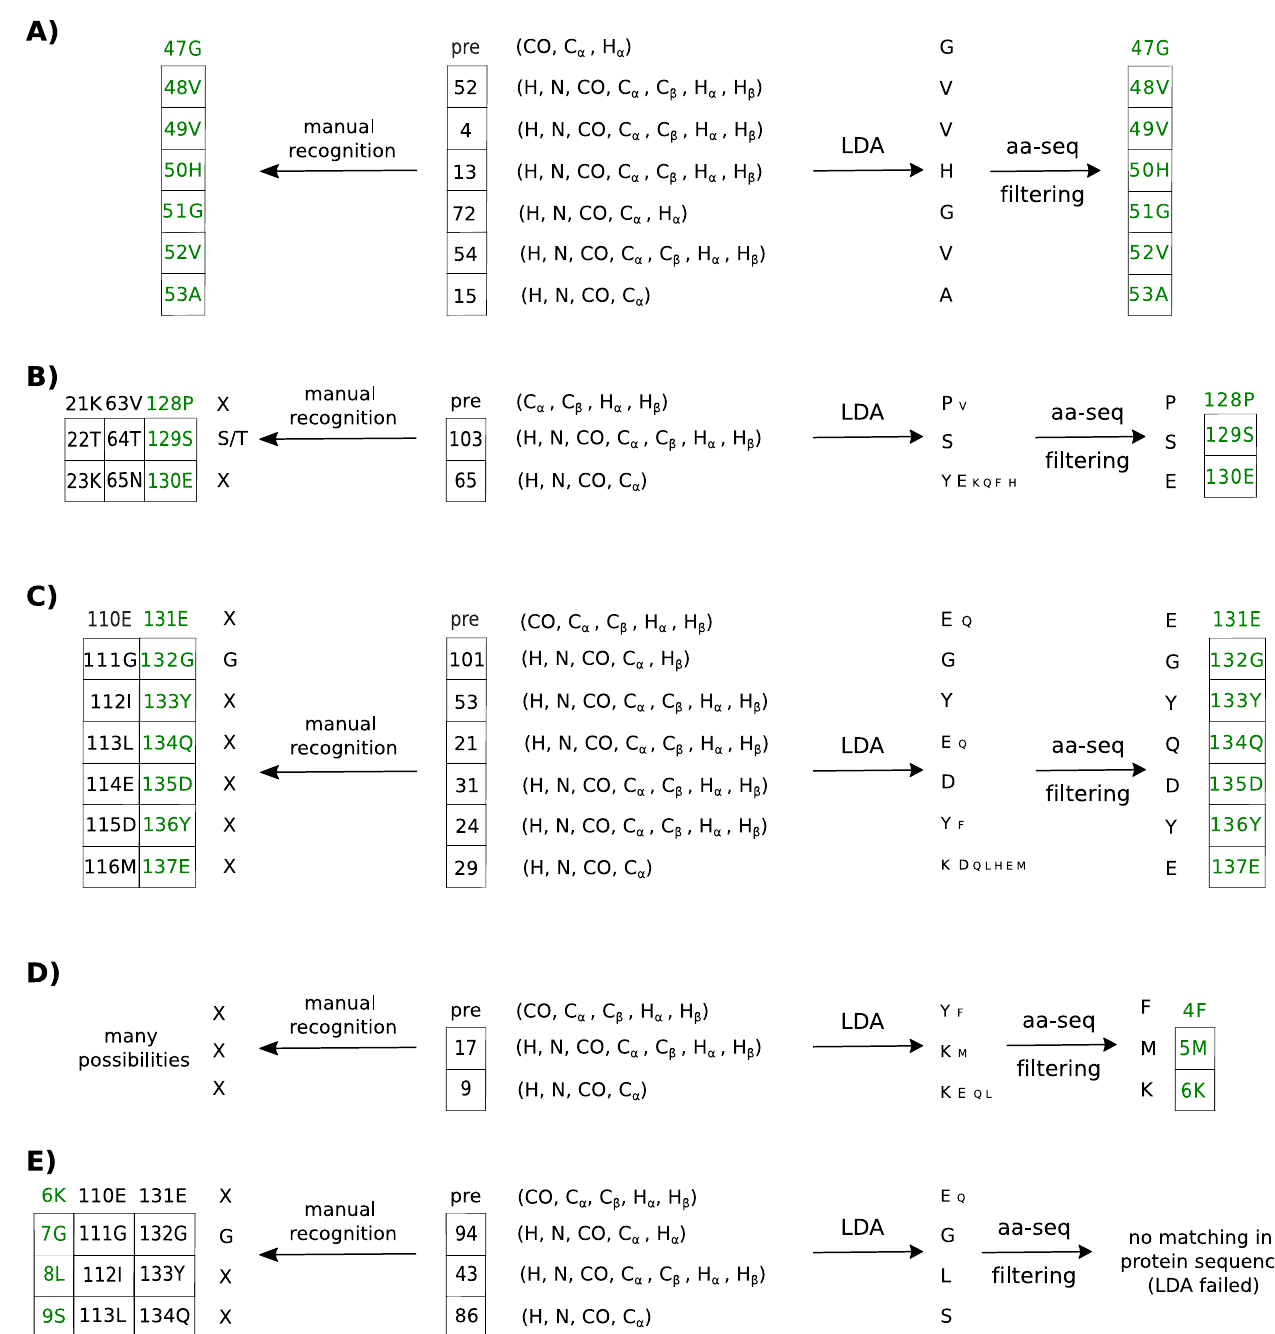
Fig 8. Comparison of the chain mapping procedure for α -synuclein with and without LDA analysis. LDA was performed using subset (iii), but in some residues, certain chemical shifts were missing and a reduced dataset was used. The numbers of the spin systems forming the chains are shown in square boxes. The label “pre” stands for the amino acid residue preceding the formed chain. The arrows labeled “LDA” point to the results of the LDA analysis, and the size of the one-letter codes corresponds to the probability as determined by LDA. The arrows labeled “aa-seq filtering” point at the results after amino-acid sequence filtering, reducing the number of possibilities. The arrows pointing left point to unambiguous manual identification of glycine, alanine, serine and threonine (“X” is used for all other amino acid types). All chains for which identification is consistent are shown on both sides, and the correct chain is marked in green. Panels A)-E) correspond to chain-mapping tasks of increasing difficulty (see Section Application 1: Mapping spin-system chains for details).